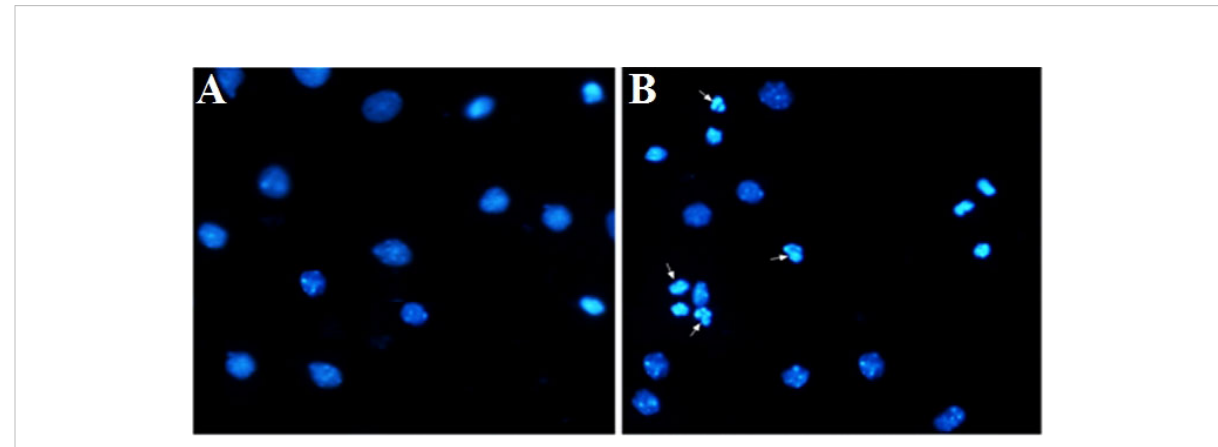
FIGURE 5 Immuno fl uorescence detection of the nucleus of hippocampal neurons under high glucose stimulation (×400). The arrow points to apoptotic bodies. (A) Glucose, 25 mM. (B) Glucose, 225 mM.